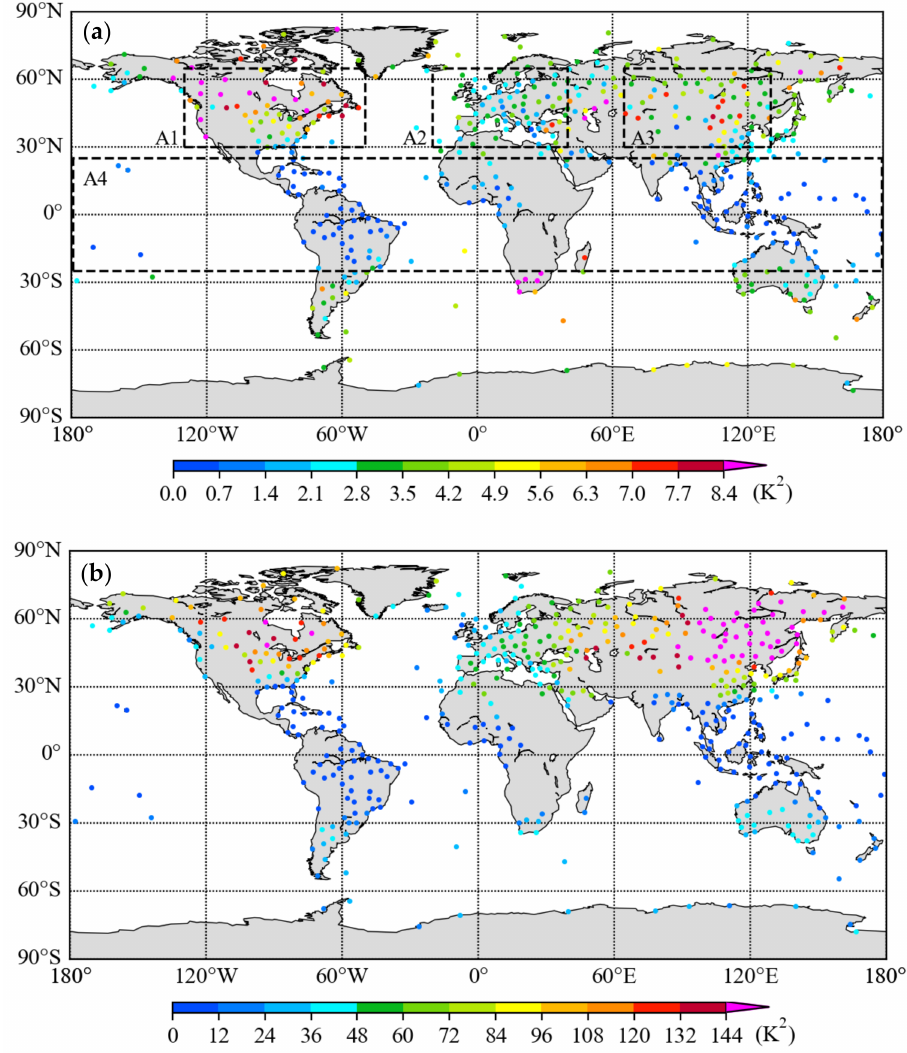
Figure 8. Global distributions of ( a ) error variance and ( b ) variance of RS temperature at 850 hPa near 521 RS stations, with four chosen areas (A1, A2, A3, and A4) framed by black dashed lines in ( a ). Figure 10 shows the error variances and variances of RS q observations at 850